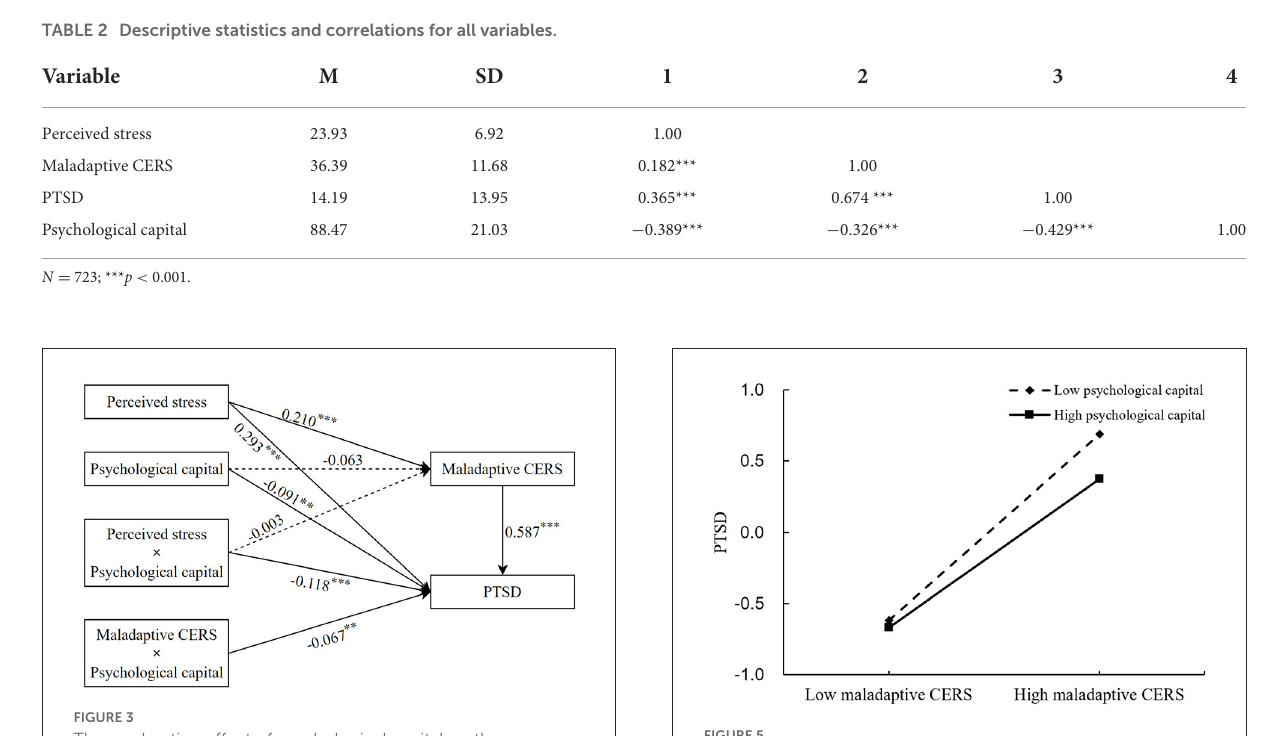
FIGURE5 Association between maladaptive CERS and PTSD symptoms at higher and lower levels of psychological